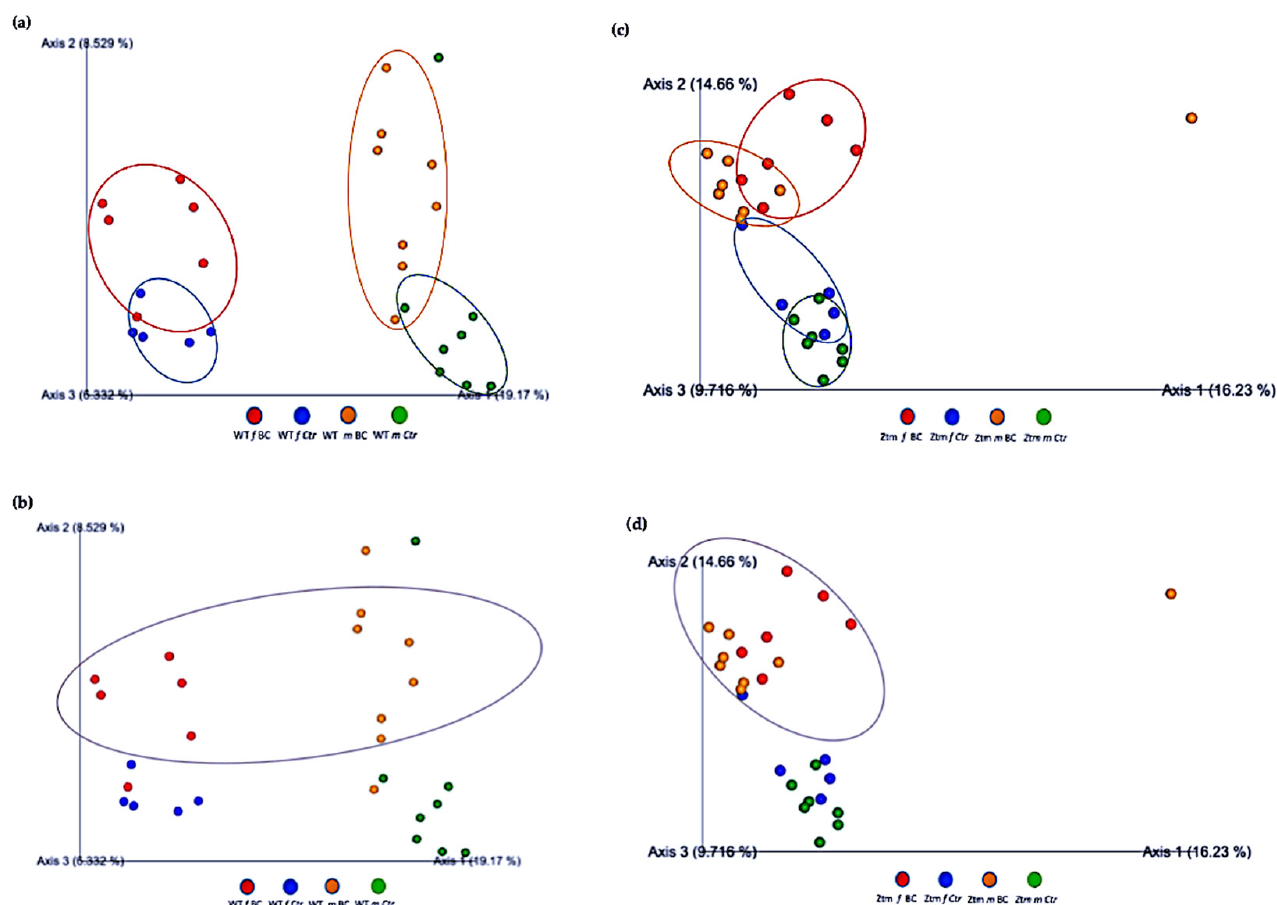
Figure 5. Beta diversity of intestinal microbial communities between WT BC and control groups, and Ztm BC and control groups. PCA plot based on Jaccard distance. Each dot on the plot represents one sample from each group. The Jaccard patterns indicate BC and Ctr representing; ( a ): WT BC ( f & m ) vs. WT Ctr ( f & m ) partially overlapping; ( b ): WT BC groups ( f & m ); ( c ): Ztm BC ( f & m ) vs.